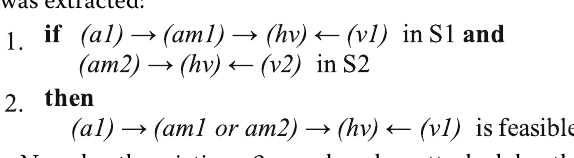
Similar to the previous analysis pattern, the following logic was extracted: